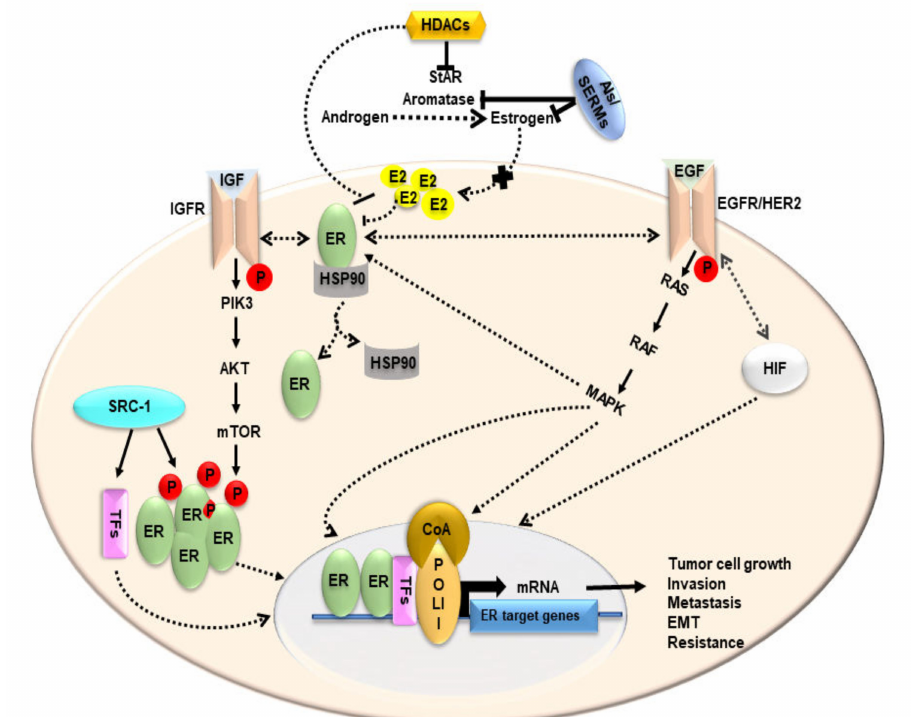
Figure 7. A schematic model illustrating various signaling processes in BCs. HDACIs decreases in StAR, aromatase, E2/estrogen levels. AIs inhibit aromatase and thereby block the conversion of an- drogens to estrogens. E2 is diminished and tumor cells engage in other non-estrogen related pathways for their growth and survival. Upon ligand activation, receptors for a number of growth factors, such as IGF and EGF, become phosphorylated (P). ER interacts with growth factor receptors (e.g., IGFR and EGFR/HER2) that trigger downstream growth signaling pathways, such as PIK3/AKT/mTOR and Ras/Raf/MAPK. This leads to phosphorylation of ER which dissociates from its chaperone HSP-90. Phosphorylated ER translocate into the nucleus to bring about transcription of ER target genes in the presence of transcriptional machinery, which consist of RNA polymerase (POL II), TFs, and coactivators (CoA). Src-1 phosphorylates ER and TFs to bring about gene transcription; whereas under hypoxic conditions, HIF mutually interacts with EGFR and results in transcriptional regulation of tumor growth-related genes. Different pathways engaged by estrogen-deprived conditions result in tumor cell growth, invasion, metastasis, epithelial to mesenchymal transition (EMT) and inhibitor resistance in